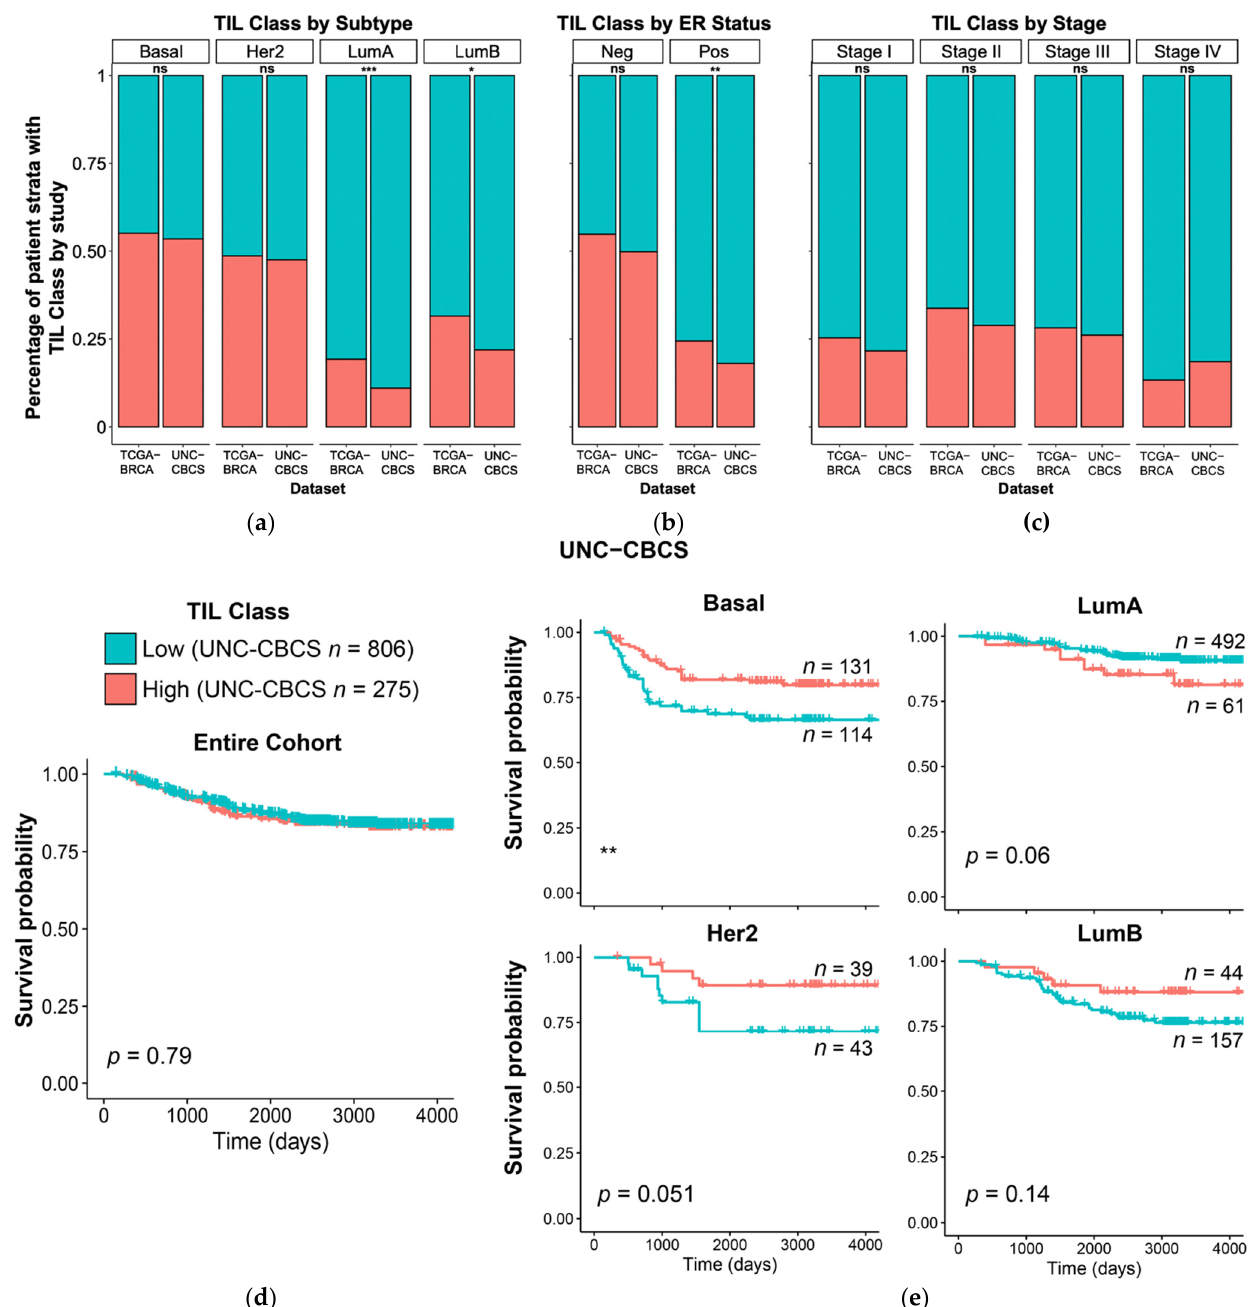
Figure 4. Comparison of computed intratumoral TIL infiltrate percentage in TCGA BRCA and UNC CBCS and relationship to progression-free interval (PFI). The median TIL infiltrate percentage was computed for each study to distinguish cases as high or low TIL class; percent infiltration was determined using VGG TIL detection algorithm. ( a – c ) Percentage of patient strata classified as high and low TILs is shown for the TCGA BRCA and UNC CBCS studies grouped by ( a ) PAM50 molecular subtype, ( b ) estrogen receptor (ER) status, and ( c ) tumor stage. Blue denotes TIL class Low and Red denotes TIL class High. ( d , e ) Kaplan–Meier plots to show disease progression in the UNC CBCS cohort after dividing patients into high and low TIL classes around the mean TIL infiltrate percentage for the ( d ) entire UNC CBCS cohort and ( e ) cases split by PAM50 molecular subtype. Log-rank test was used to assess survival differences. *** = p < 0.001, ** = p < 0.05, * = p < 0.01.